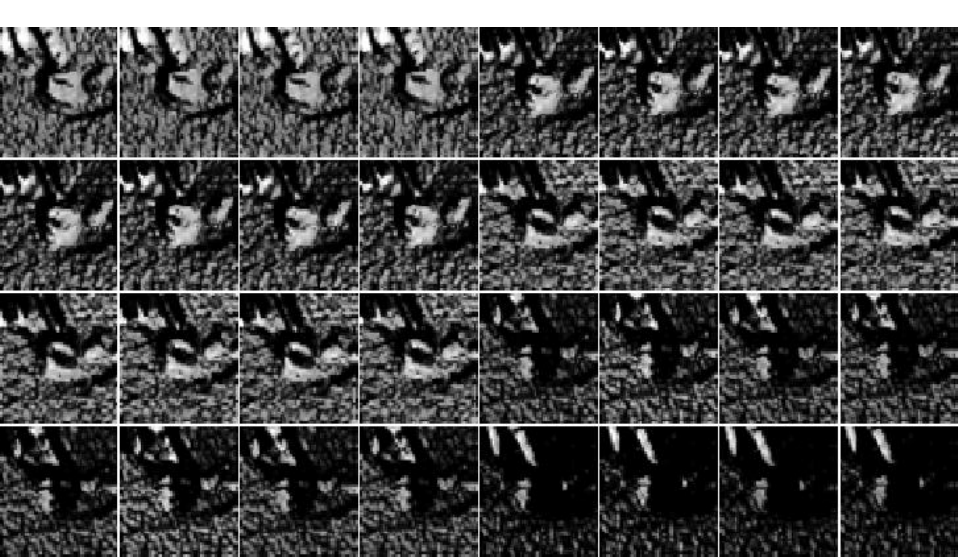
Figure 7. The first 32 channels of AS 3D HOG